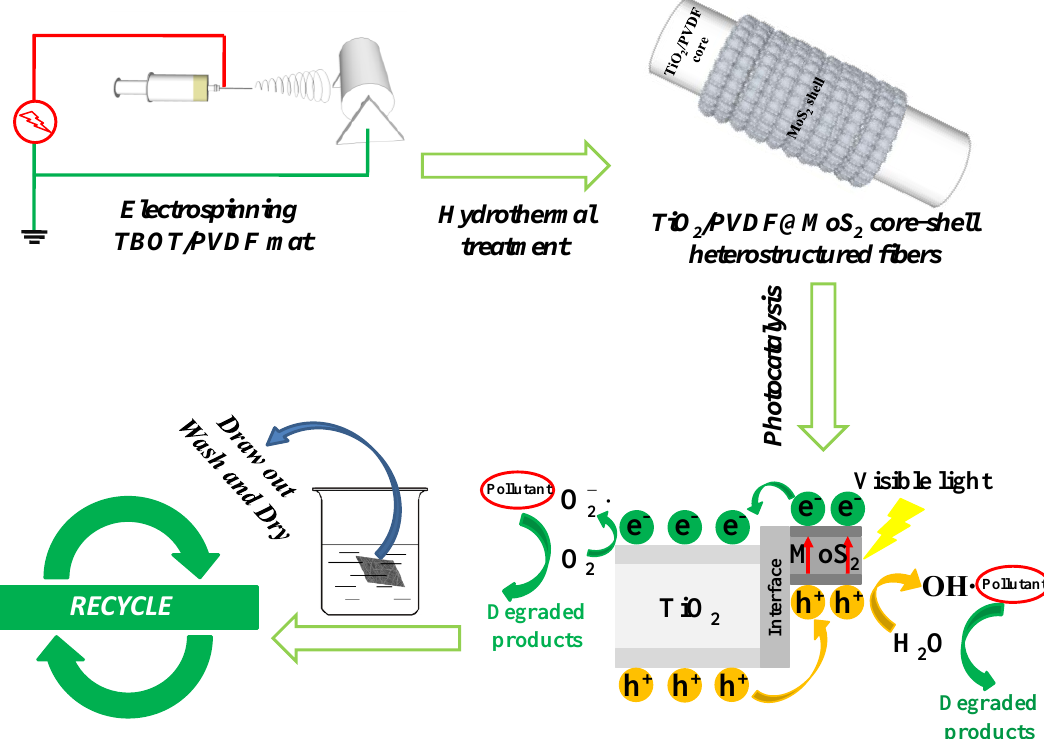
Figure 1. Schematic illustration for the synthesis and application process of TiO 2 /PVDF@MoS 2 core-shell heterostructured fibers.